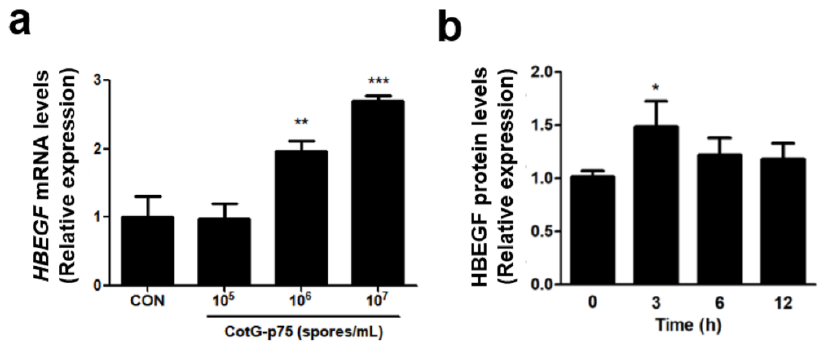
Figure 8. Effect of CotG-p75 on HBEGF mRNA expression ( a ) and HBEGF protein production ( b ). In panel ( a ), cells were treated with various concentrations of CotG-p75 (10 5 to 10 7 spores/mL) for 3 h. In panel ( b ), cells were treated with CotG-p75 (10 7 spores/mL) during various times (0, 3, 6, and 12 h). The mRNA expression levels and protein production levels in treated groups were compared with the control group. All data are expressed as mean ± standard deviation ( n = 3). Asterisks (*) indicate a significance difference from the control (* p < 0.05, ** p < 0.01, *** p < 0.001).